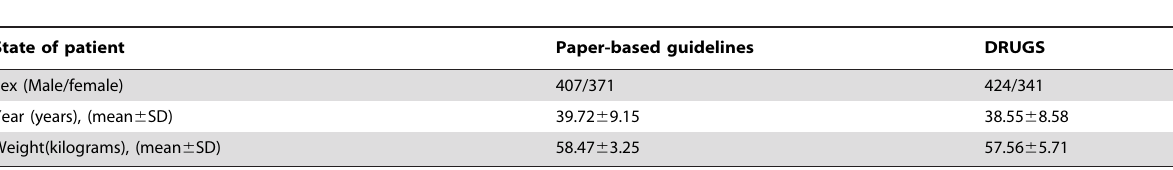
Table 1. Characteristics of patients in each period before and after